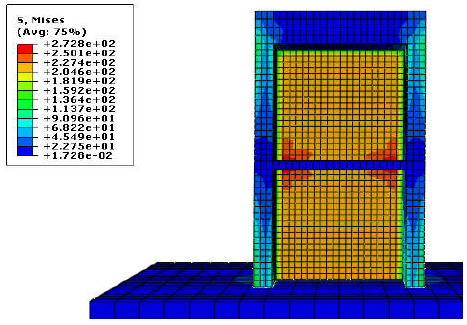
Figure 3. Mises stress Created in Model (kN/mm 2 ).